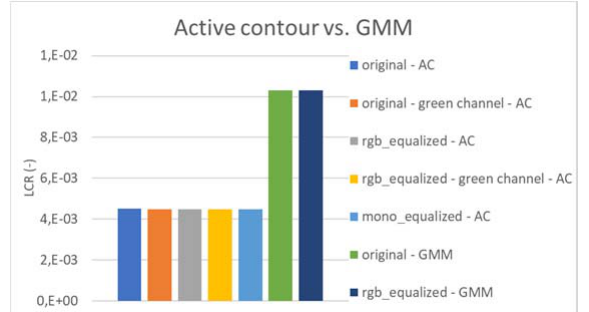
Fig. 15. Liquid content ratio of the images. Different number of iteration was tested, started at 100 ended at 1500. After 500 iteration the results stopped varying.